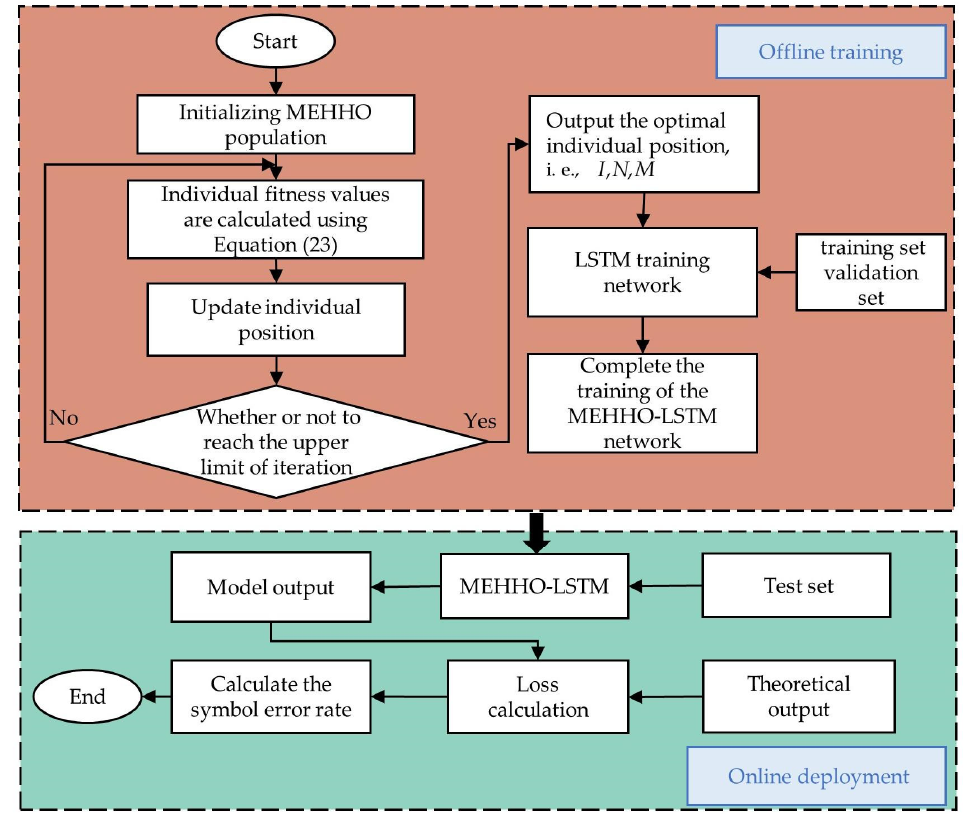
Figure 6. MEHHO ‐ LSTM model channel estimation and signal detection process. Figure 6. MEHHO-LSTM model channel estimation and signal detection